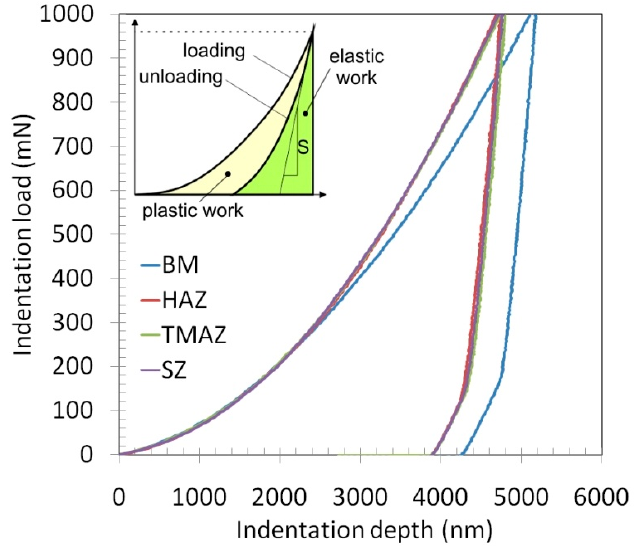
Figure 7. Indentation curves for different zones of RFSSW joint (experiment E2).